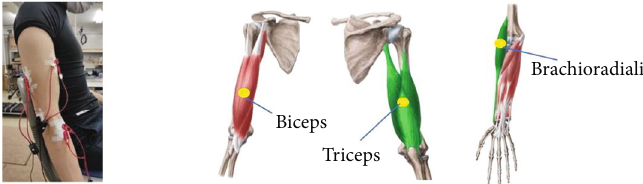
Figure 7: EMG signals were recorded from sets of electrodes attached to the muscles of interest (biceps, triceps, and brachioradialis), while the subjects were weighted with a load on the wrist.